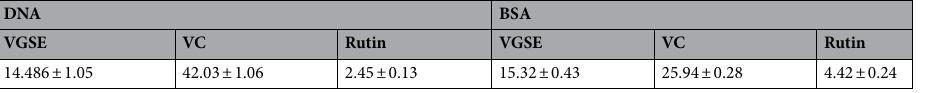
Table 4. In vitro DNA and BSA damage inhibition activity. IC 50 (µg/mL) is the concentration of VGSE, VC, or rutin that can inhibit DNA and BSA damage by 50%. Values are means ± SD of three experiments. Analysis was achieved using GraphPad Prism software (version